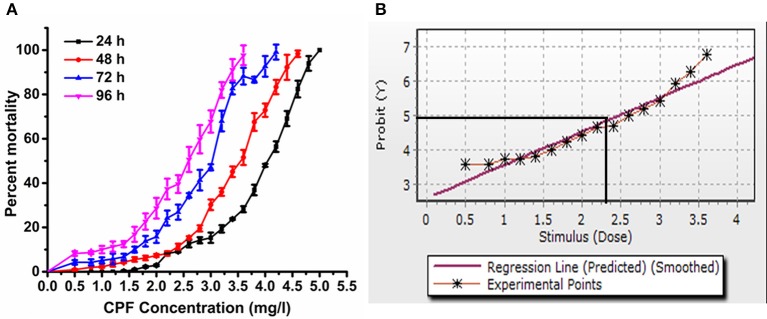
(A) Mortality percentage of P. ricini to different concentrations of chlorpyrifos at 24, 48, 72, and 96 h, and (B) probit analysis graph for 96 h exposure period, the experiment was performed three times in triplicates (n = 50).